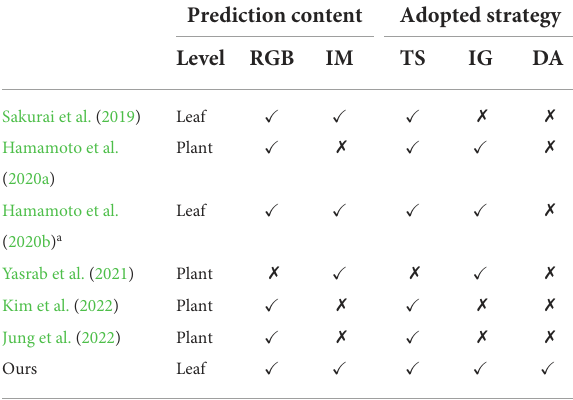
TABLE 1 Related study is considered from two points, the predicting content and the adopted